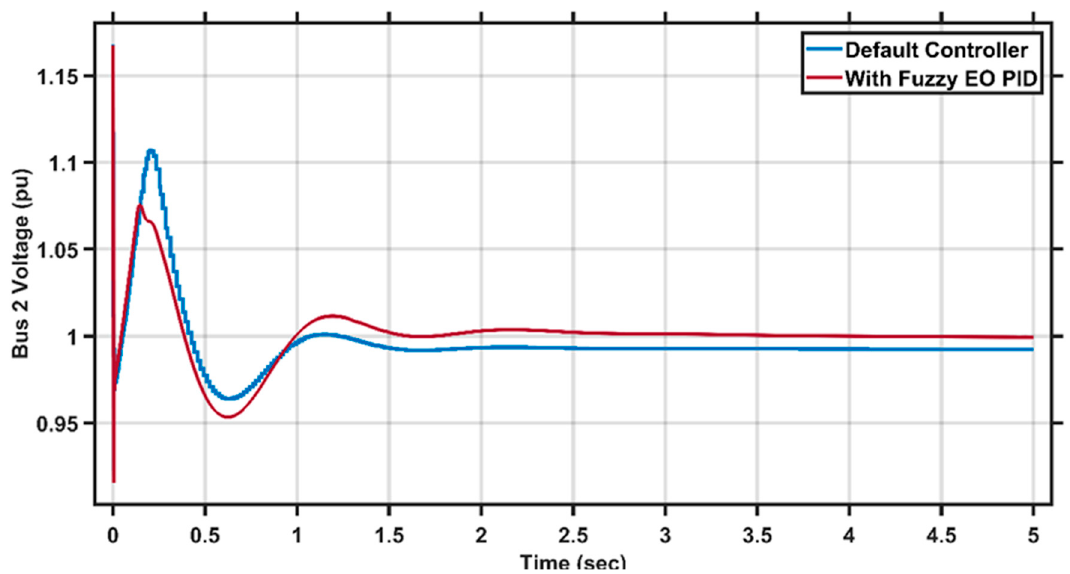
Figure 20. Bus 2 voltage at normal operation for the IEEE 9-bus system.